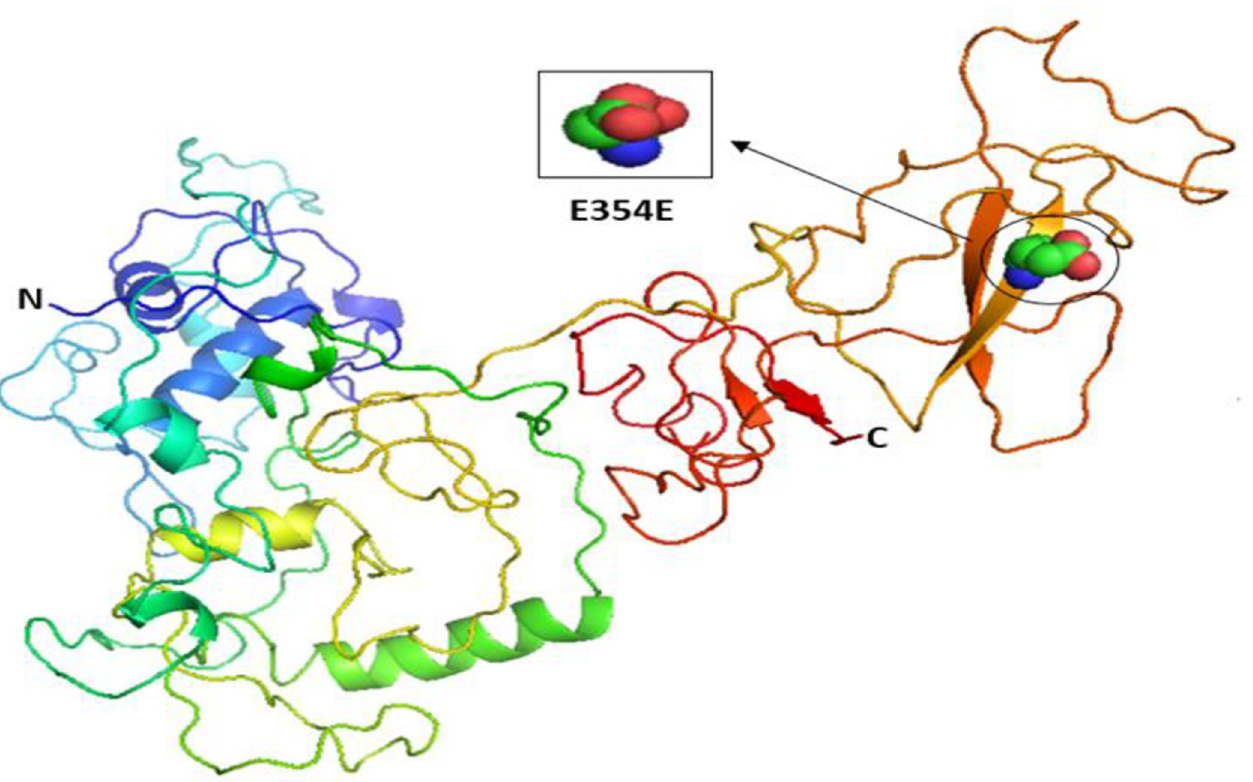
Fig 3. The 3D structures of normal and mutated MDM2